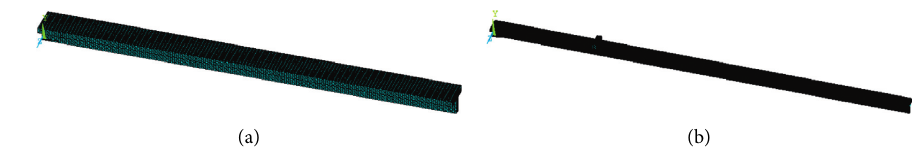
Figure 8: FEA model of example 2. (a) Case 1. (b) Case 2 and Case